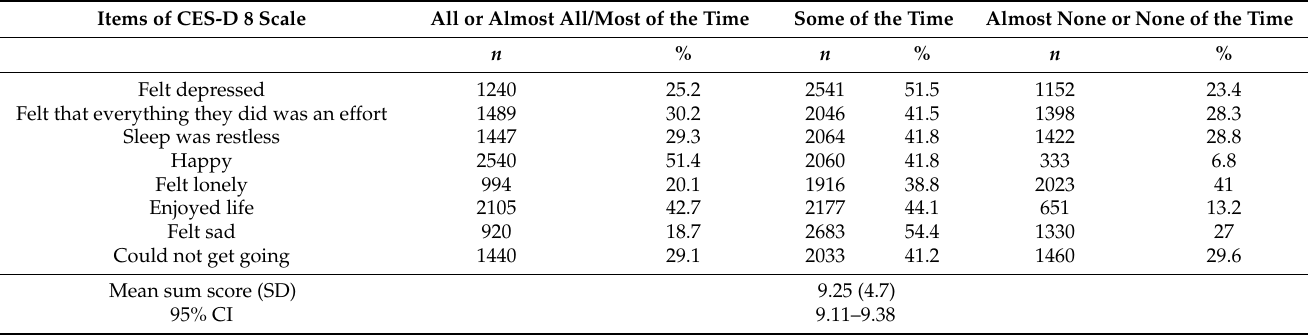
Table 2. Description of subjective depressive